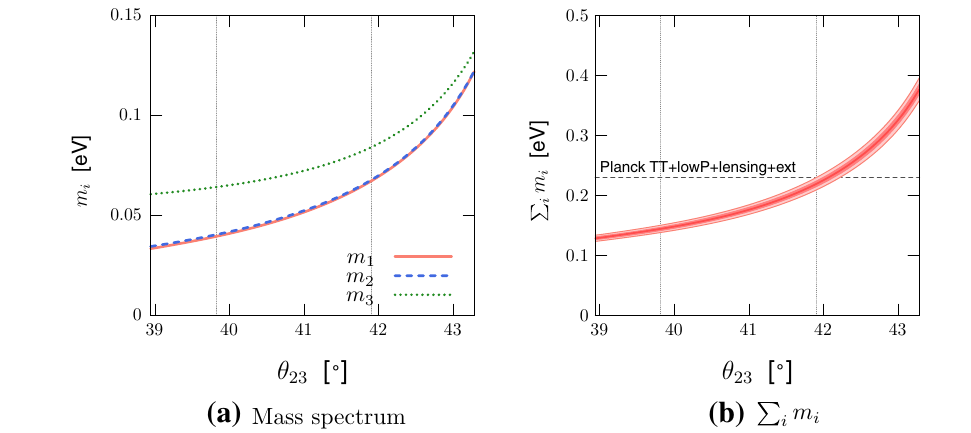
Fig. 3 a The prediction for the neutrino masses in the minimal gauged U ( 1 ) L μ − L τ model. The neutrino masses m i are shown as functions of θ θ δ m 2 , and (cid:6) m 2 ) are fixed to θ 23 . The other four parameters ( 12 , 13 , their best-fit values. b The sum of the neutrino masses as a function of θ 23 . The dark (light) red band shows the uncertainty coming from the